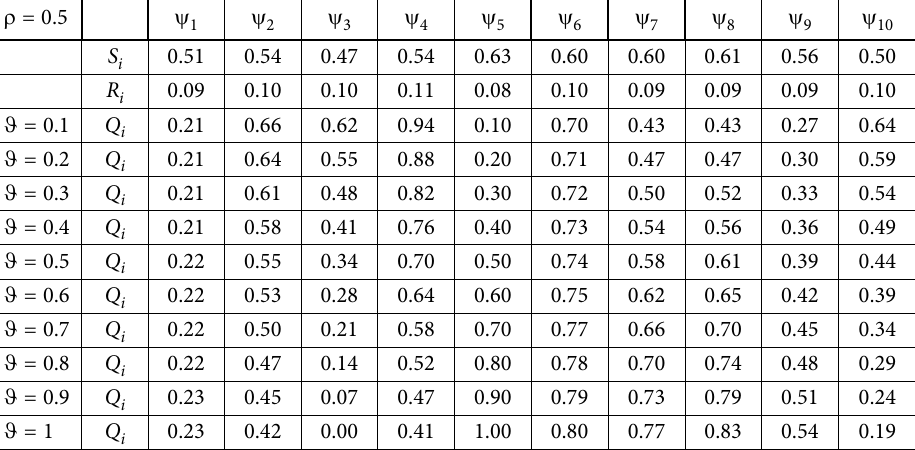
Table 11. The final results with r = 0.5 and J ∈ [0,1] r =